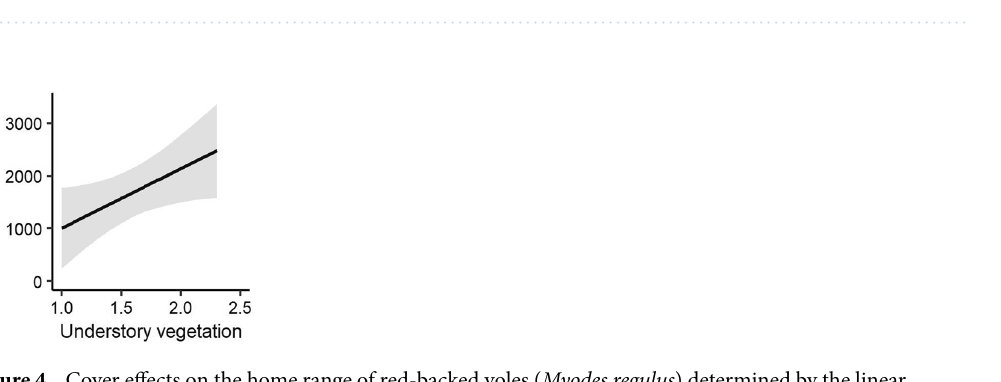
Figure 3. Climatic effects on the home range and core area of red-backed voles ( Myodes regulus ) determined by the linear models.